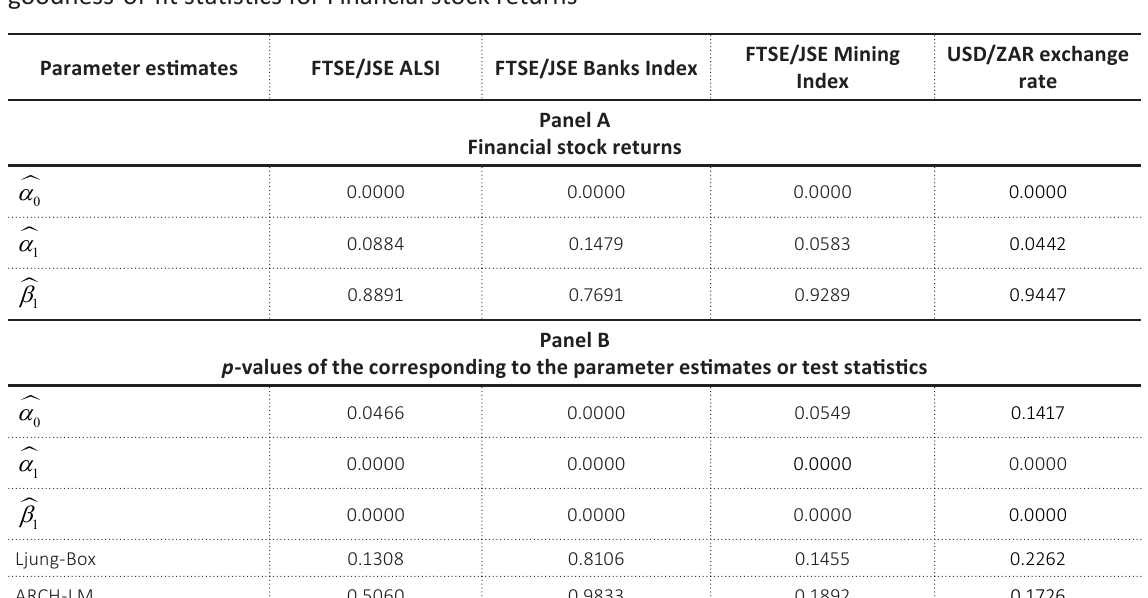
Table 1. Positive averages for FTSE/JSE ALSI and FTSE/JSE Mining Index returns indicate a slight increasing trend over time, whereas the negative averages for the FTSE/JSE Banks Index and USD/ ZAR exchange rate returns indicate a slight de- creasing trend over time for the return series. Tests for normality, autocorrelation and hetero- scedasticity are shown in Panel B. The null hy- pothesis of normality for the Jarque-Bera test is rejected at the 5% level of significance for all re- turns. This implies that the use of heavy-tailed models should be considered when analyzing the returns series.